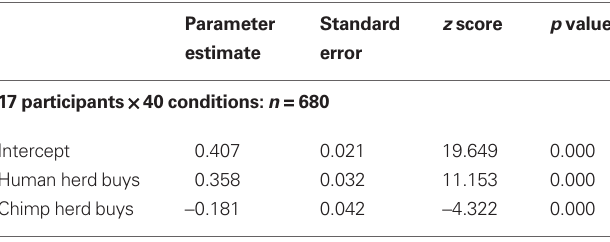
Table 1 | Logistic estimation results (standard normal